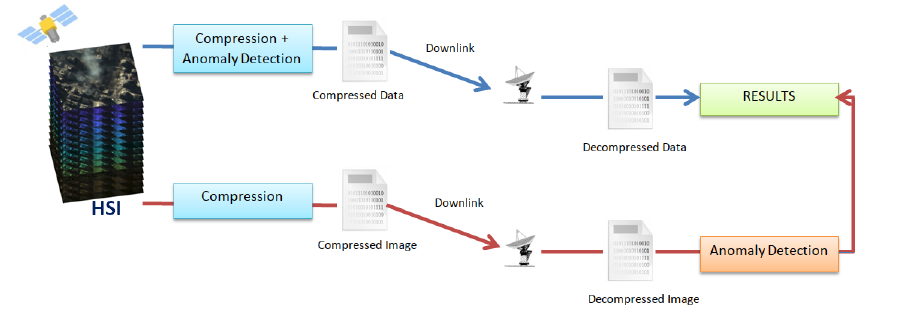
Figure 8. Block Diagram of the processes involved in the proposed method (blue arrow) versus those involved when images are on-board compressed, and the anomaly detection process is off-line performed (red arrow).